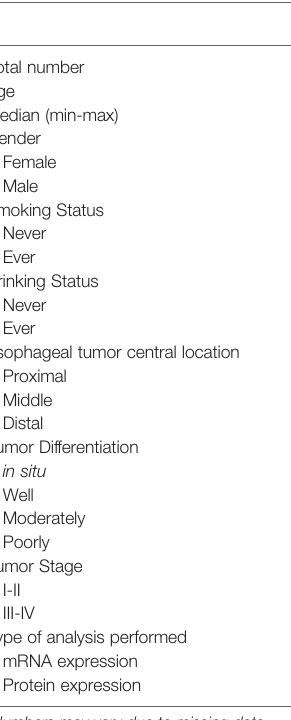
TABLE 1 | Characteristics of the individuals included in the